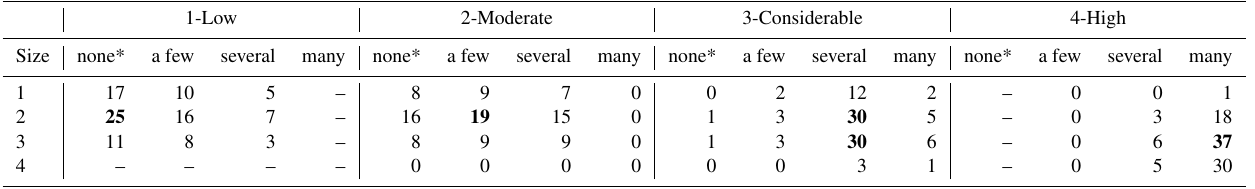
Table 3. Table showing the combination of the frequency class of very poor snowpack stability and the largest avalanche size for the four danger levels. Frequencies are rounded to the full percent value. Bold values highlight the most frequent combination; “–” indicates that these combinations did not exist.